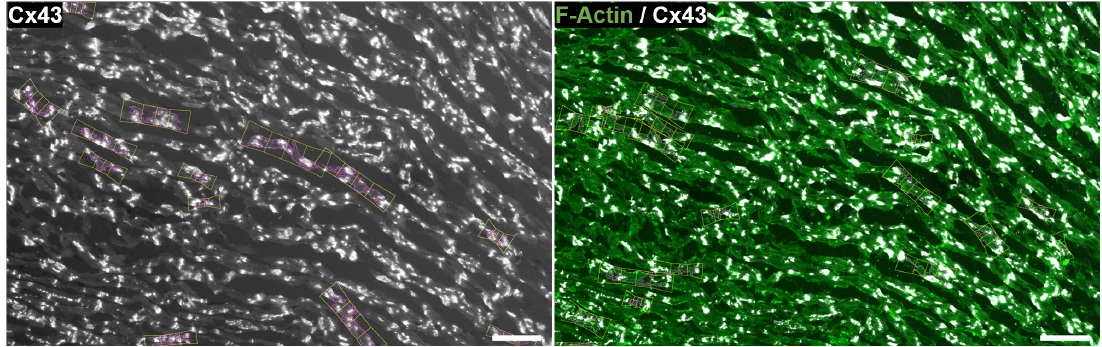
Figure 13. Detected CMs in the automatic mask M a computed under the supervised mode for images d 1 ( left ) and d 2 ( right ). Scale bar = 100 µ